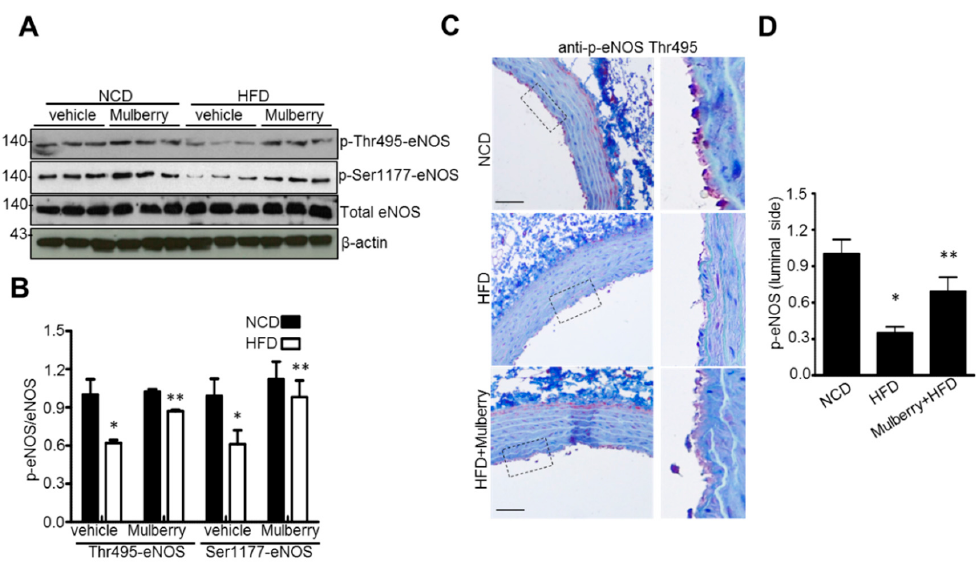
Figure 5. Mulberry recouples eNOS in hyperlipidemic rats. Rats were given a normal diet or a high-fat diet with or without 100 mg/kg mulberry for six weeks, and aorta rings were harvested. Phosphorylation of Ser1177 and Thr495 ( A ) and expression of total eNOS and β -actin in the aorta ( B ) were determined by Western blotting. Values are presented as mean ± SEM. ( n = 3; * p <0.05 versus the NCD group; ** p <0.05 vs. the HFD group) ( C ) Representative images of the immunohistochemical staining of phosphorylation of eNOS at Thr495 (p-eNOS) on aortic sections. Scale bars, 50 µm. ( D ) Quantification of phosphorylation of eNOS at Thr-positive luminal side. Values are presented as mean ± SEM. ( n = 6. * p <0.05 versus the NCD group; ** p <0.05 versus the HFD group). NCD, normal control diet; HFD, high-fat diet.